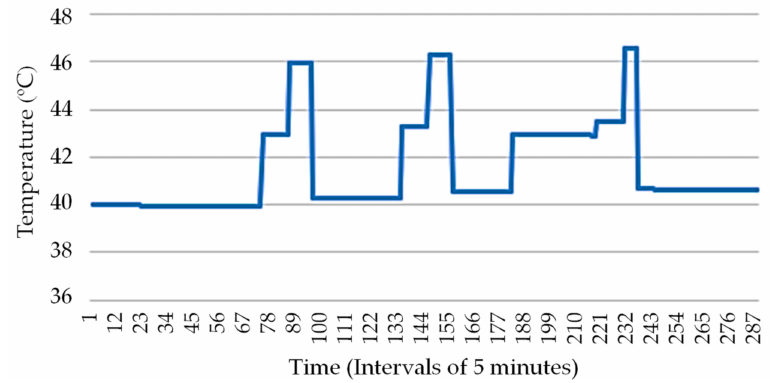
Figure 12. Evolution of the temperature in the sanitarian water heater tank, during the day considering time of use scheme.